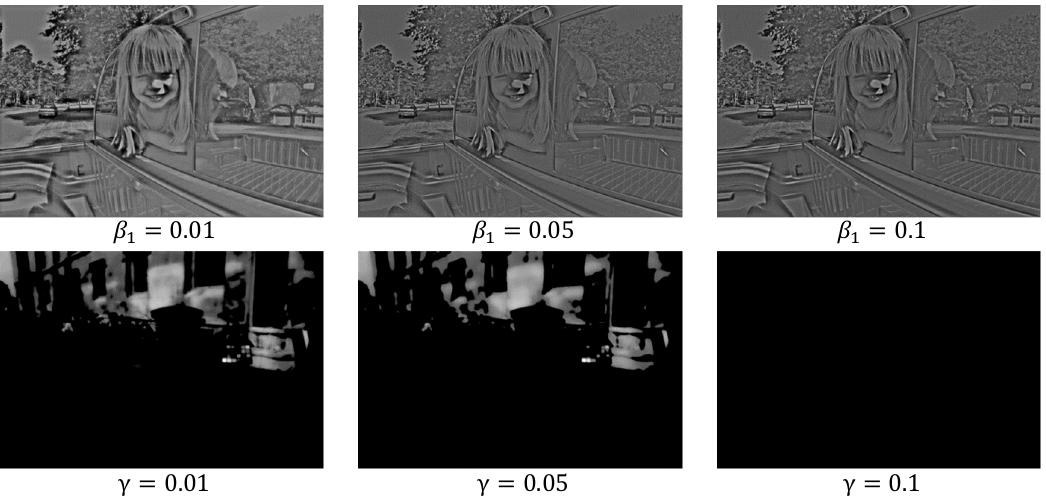
Figure 4. Variation of feature map for various β 1 and γ